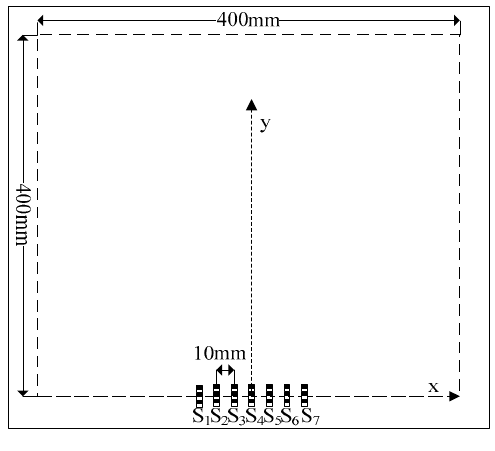
Figure 8. Localization experiment.